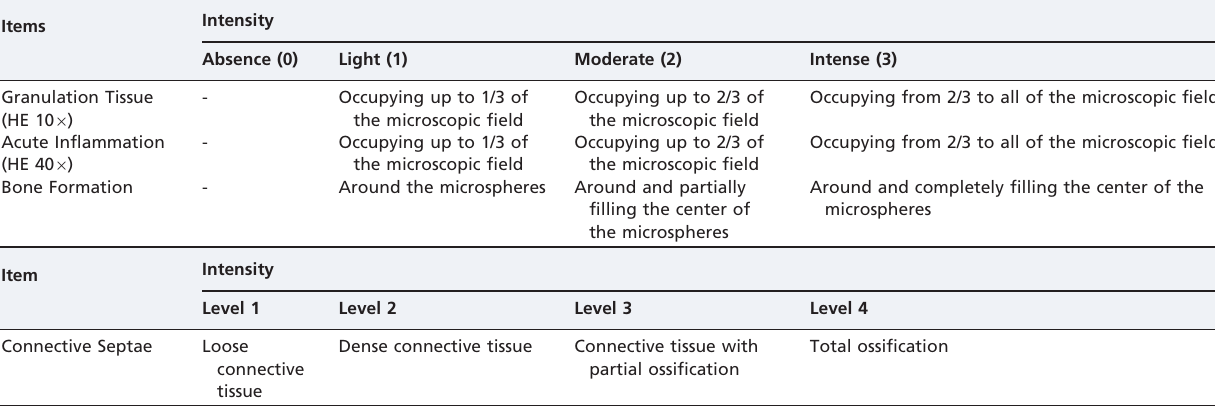
Table 1 - Estimated histopathological features used in the semi-quantitative